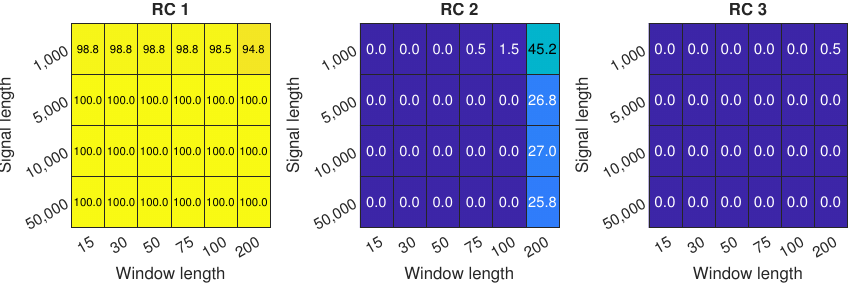
Figure 13. Surge detection accuracy for RCs 1 to 3 with different signal length N and different window length L